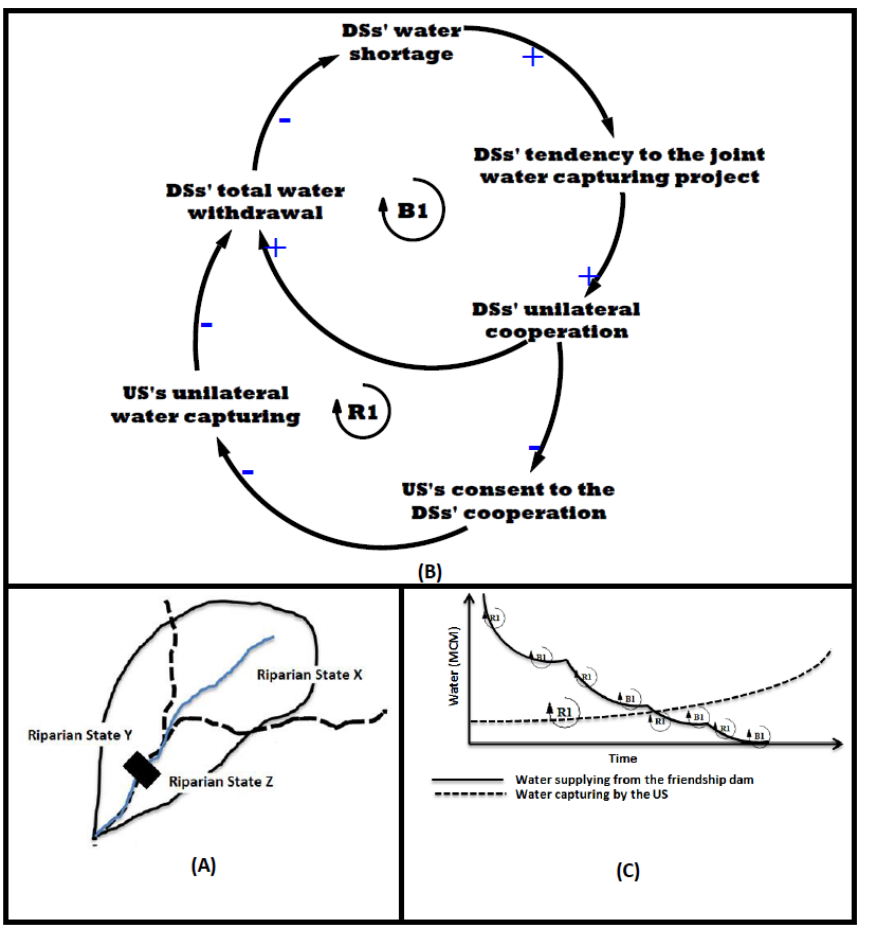
Figure 3. ( A ) The schematic of the physical environment that can embrace HSA3 (real cases